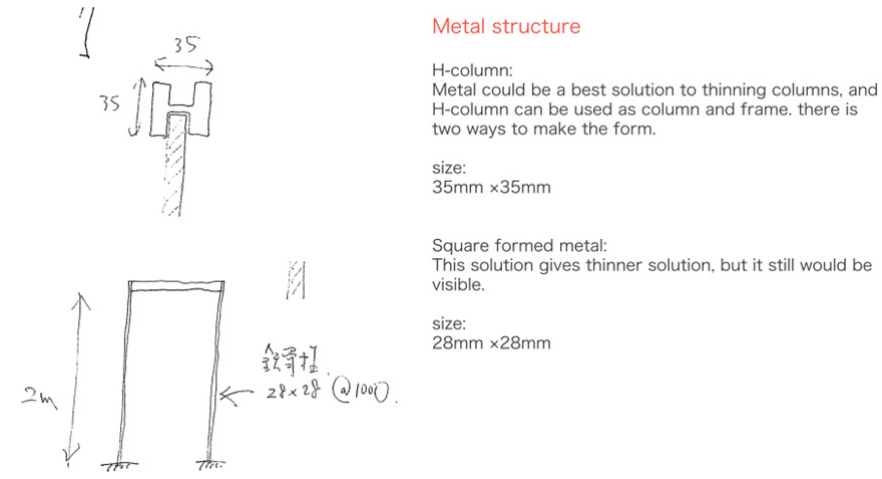
Fig. 10 Proposal from Japanese structural engineer for small columns in between panels.